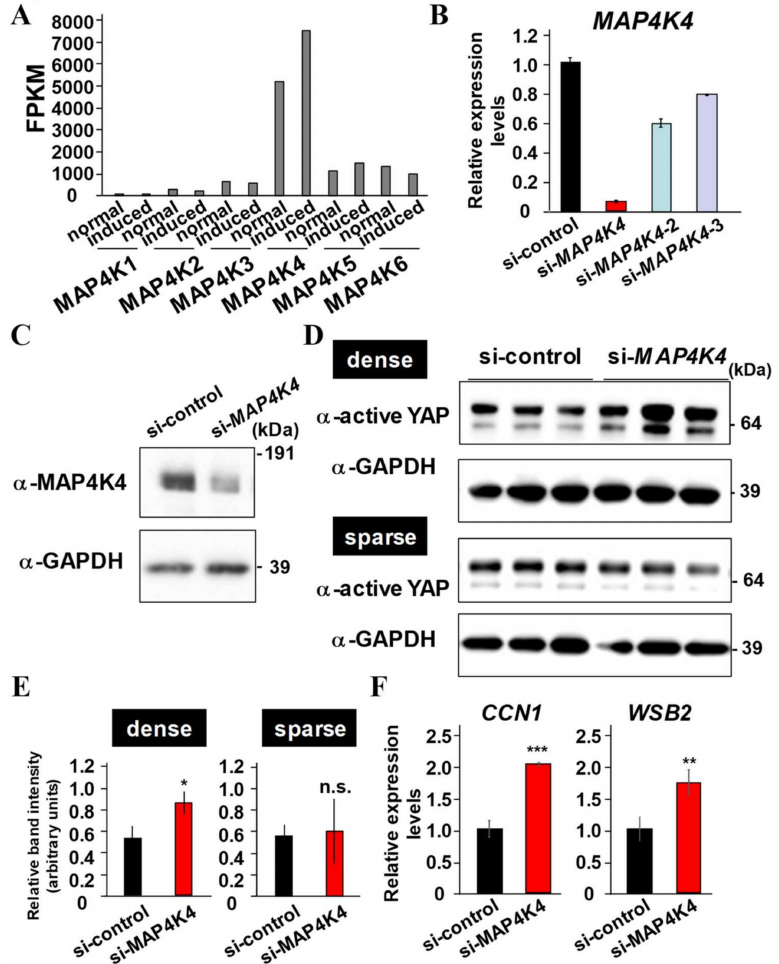
Figure 6. Identification of MAP4K4 as principle MAP4Ks for YAP activation in PDLF. ( A ) Six kinds of MAP4K4s coding gene expression in PDLF. Processing of RNA-seq data reveals MAP4K4 was highly expressed before and after the osteo/cementogenic induction compared with other MAP4Ks in PDLF. ( B ) Three independent siRNAs for MAP4K4 were transfected into PLDF and total RNA was collected to quantify the expression of MAP4K4 . HPRT was used for normalization. ( C ) PDLF were transfected with si-control or si- MAP4K4 for 24 h, and whole cell lysate was collected and MAP4K4 expression was examined using specific antibodies. The membrane was also incubated with the antibody for GAPDH as a loading control. ( D , E ) PDLF were transfected with si-control or si- MAP4K4 for 24 h and then re-seed with dense (1.2 × 10 6 /well in a 6-well plate) or sparse (1.5 × 10 5 /well in a 6-well plate) density and then cultured for another 24 h. Whole cell lysate was collected and the activation of YAP was examined using a specific antibody ( D ). Band intensities are normalized against those obtained using the antibody for GAPDH ( E ). ( F ) PDLF were transfected with si-control or si- MAP4K4 for 24 h and then re-seed with high density and then cultured for another 24 h. Then, total RNA was collected to quantify the expression of CCN1 and WSB2 . HPRT was used for normalization. * p < 0.05; ** p < 0.01; *** p < 0.001 significantly higher than the cells transfected with si-control. n.s. = not